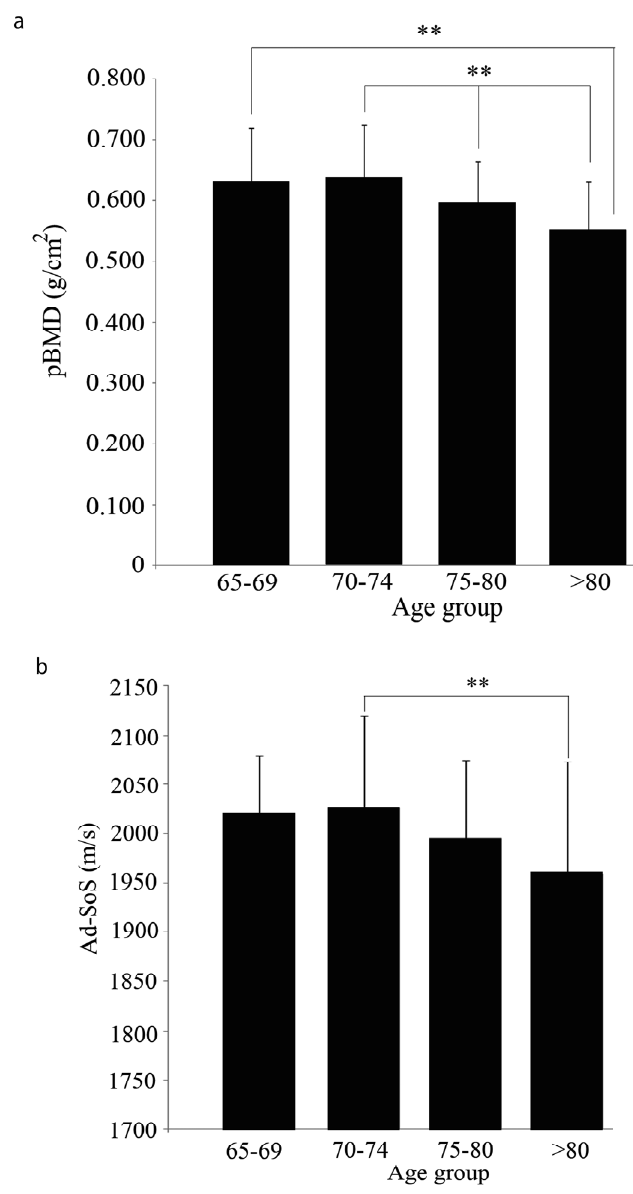
Figure 4. Bone mass in the <800 mg/day calcium intake group by age group. ( a ) pBMD and ( b ) QUS at the phalanges. ** ( p <